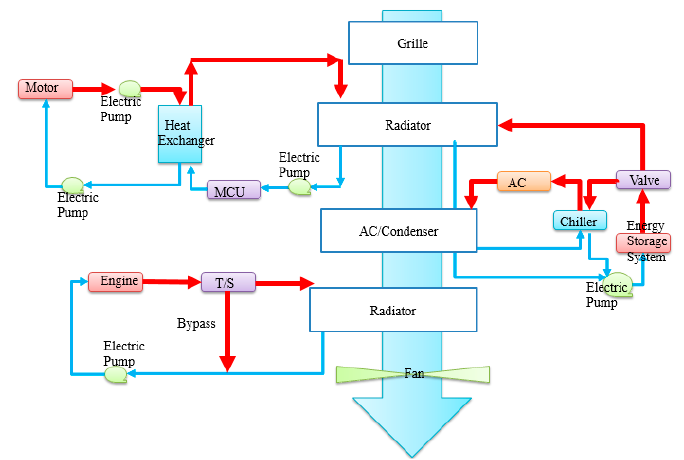
Figure 9. VITM introduced in [152].